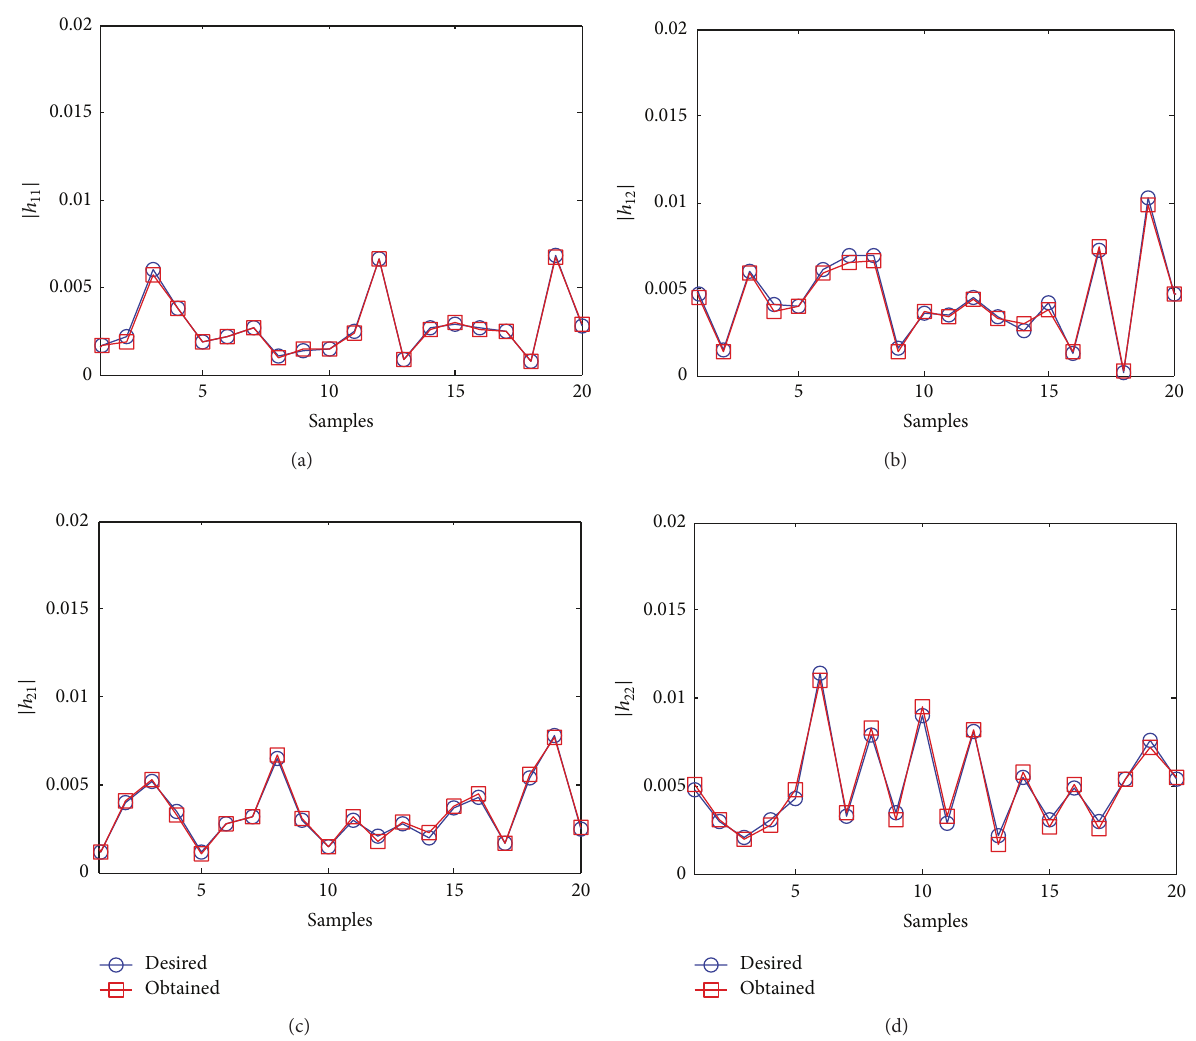
Figure 4: Comparison between the desired channel H [𝑛] and the actual emulated channel H 𝑒 [𝑛]